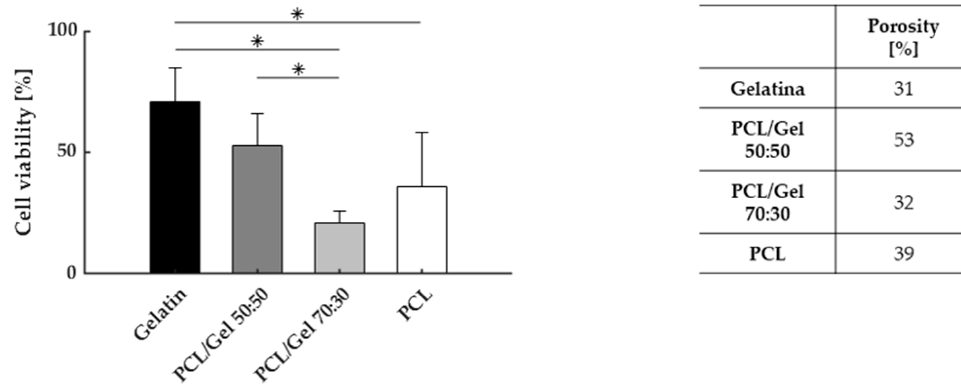
Figure 5. Cell viability, for different proportions of PCL and gelatin (left) and respective porosity values. (* p-value < 0.05)